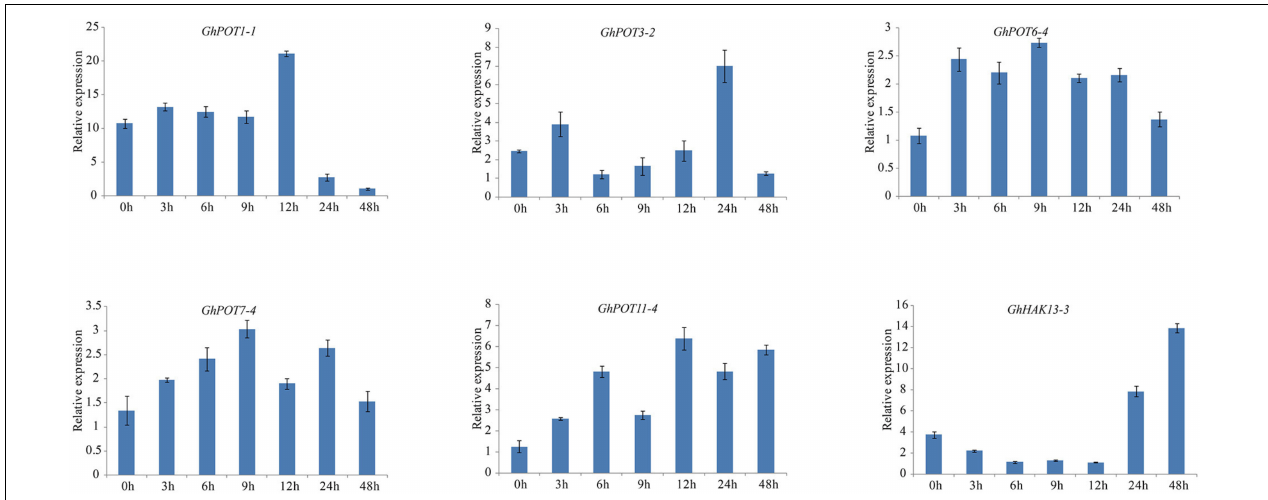
FIGURE 10 | Expressions of GhPOT genes in response to salt stress (300 mM NaCl). The expressions of the GhPOT genes were determined by qRT-PCR using the total RNA isolated from TM-1 leaves at different time points (0, 3, 6, 9, 12, 24 and 48 h) of potassium deficiency stress. The error bars indicate the standard error (SE) of three biological